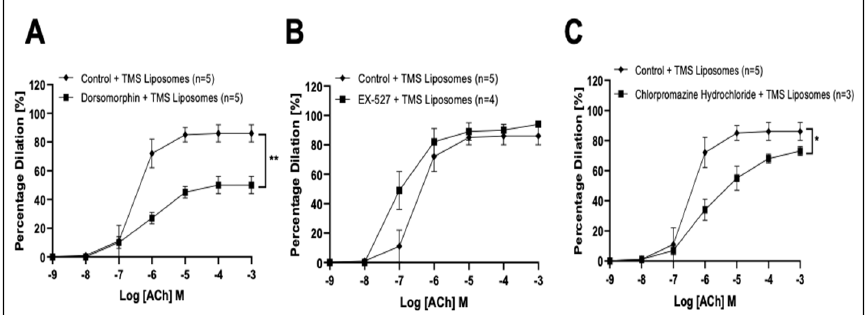
Figure 4. Characterization of the molecular mechanisms stimulated by Tetramethoxystilbene (TMS)-loaded liposomes following acute pressure elevation in isolated coronary arteries ex vivo. The influence of (5 ′ adenosine monophosphate-activated protein kinase (AMPK) inhibitor, Dorsomorphin; ( A )), (Sirtuin-1 (SIRT-1) inhibitor, EX-527; ( B )); and Chlorpromazine hydrochloride; ( C )) on acetylcholine (ACh)-induced dilation in the presence of tetramethoxystilbene (TMS)-loaded liposomes following acute pressure elevation. Control + TMS Liposomes ( n = 5); Dorsomorphin + TMS Liposomes ( n = 5); EX-527 + TMS Liposomes ( n = 4); Chlorpromazine Hydrochloride + TMS Liposomes ( n = 3). The area under the curve for two groups were compared using Two-way ANOVA followed by Tukey’s multiple comparisons post-test. Data are presented as mean ± SEM. * p < 0.05, ** p < 0.01.